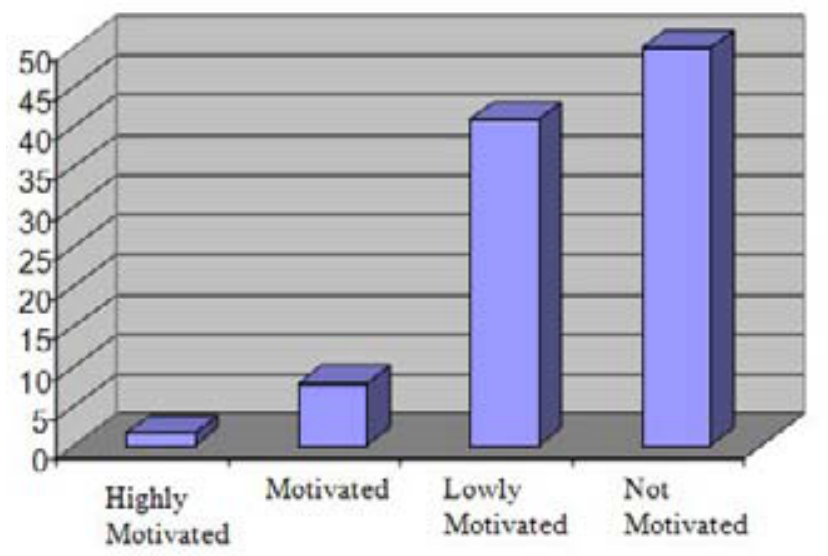
Figure 4 . Levels of motivation of lecturers in